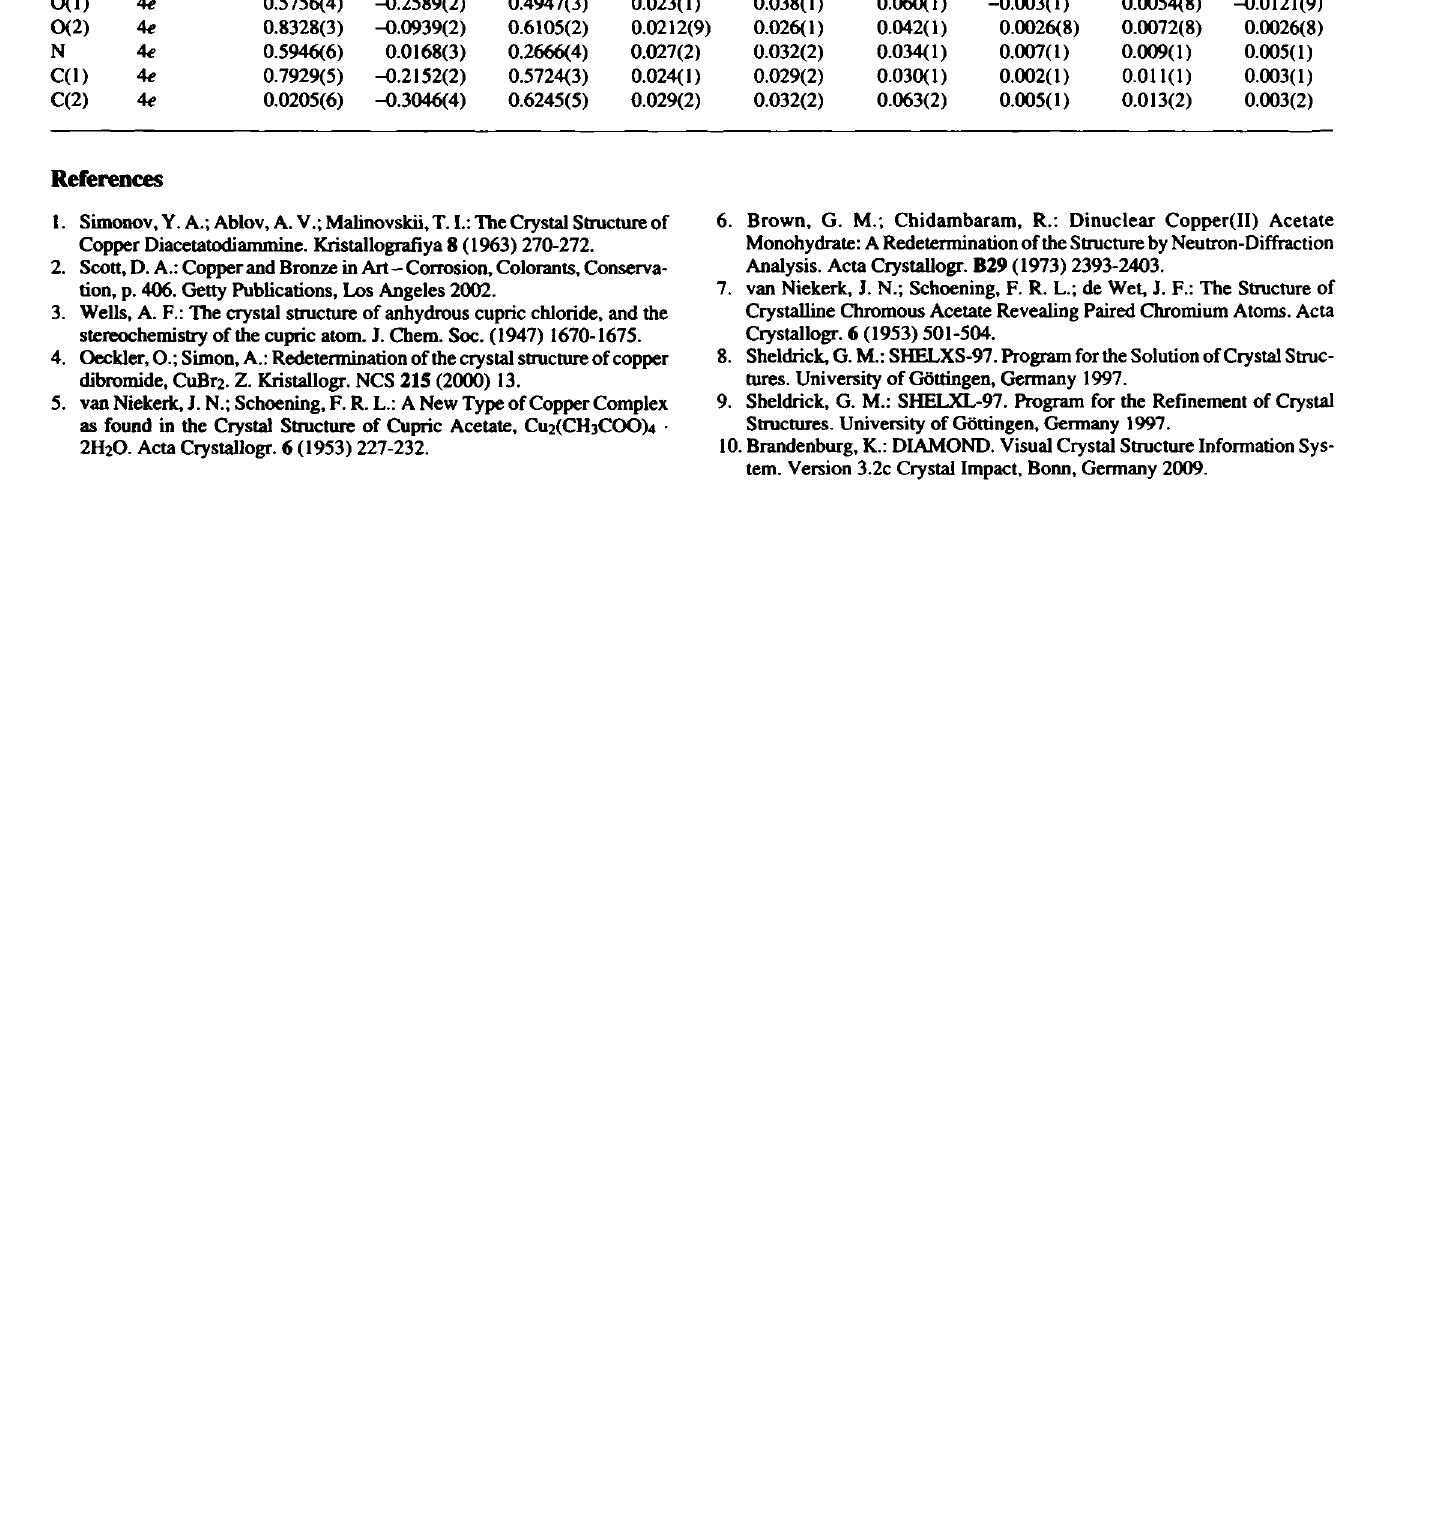
Table 3. Atomic coordinates and displacement parameters (in Â 2